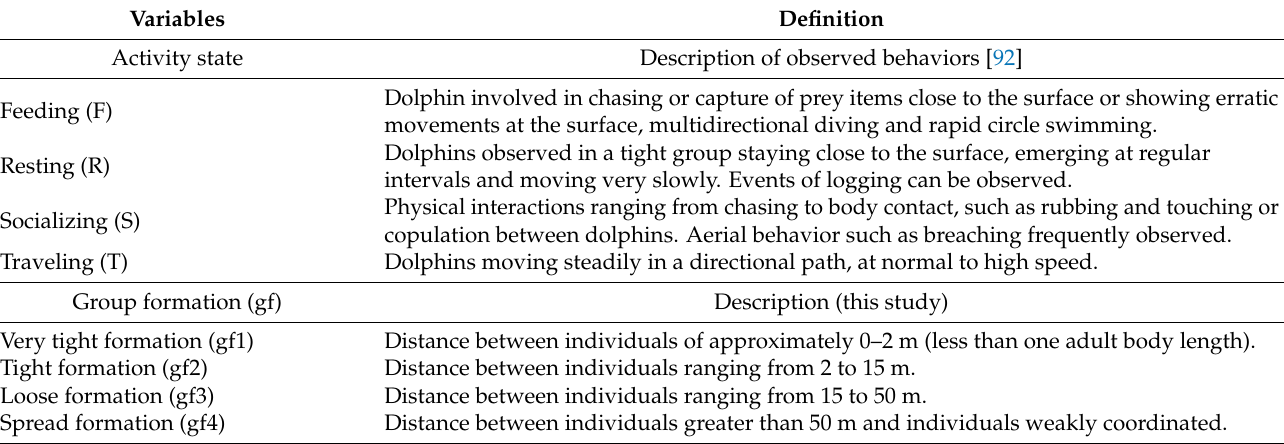
Table 1. Description of activity states and of a set of variables, characterizing the focal group, recorded during sightings of Risso’s dolphin carried out in the Gulf of